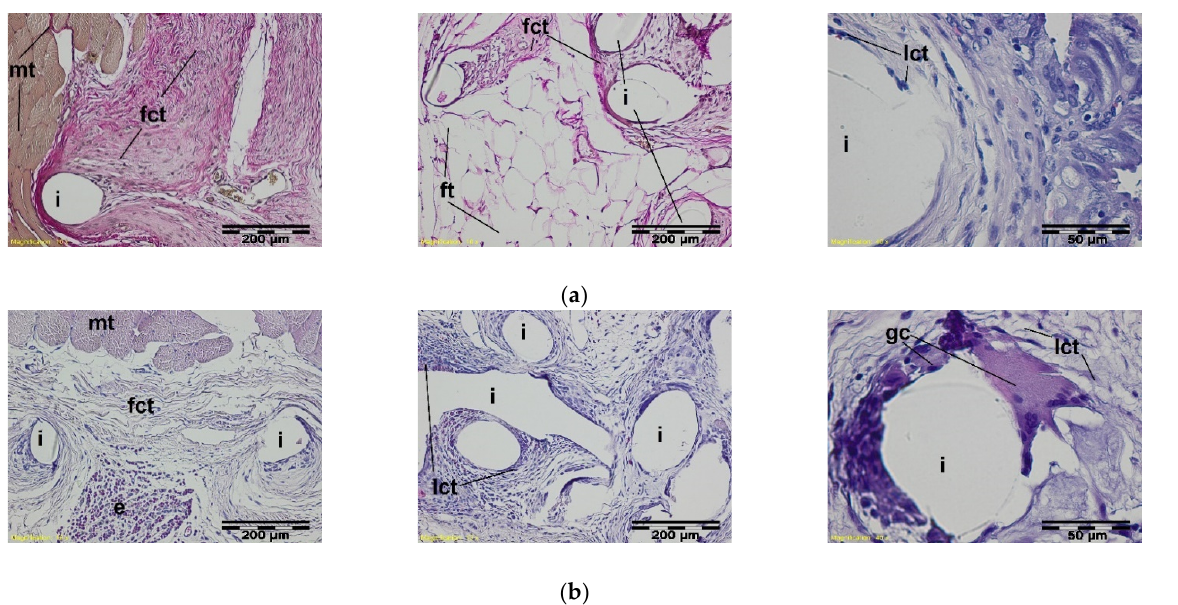
Figure 10. A microscopic view of the PACVD-modified implant ( a ) and reference ( b ) 4 weeks after the implantation in the abdominal wall of a NZW rabbit. The monofilaments of knitted structures (i) are surrounded by fibrous connective tissue (fct) from the side of the muscles (on the left) of the abdominal wall and peritoneal cavity (pc) (in the middle). On the right side, the loose connective